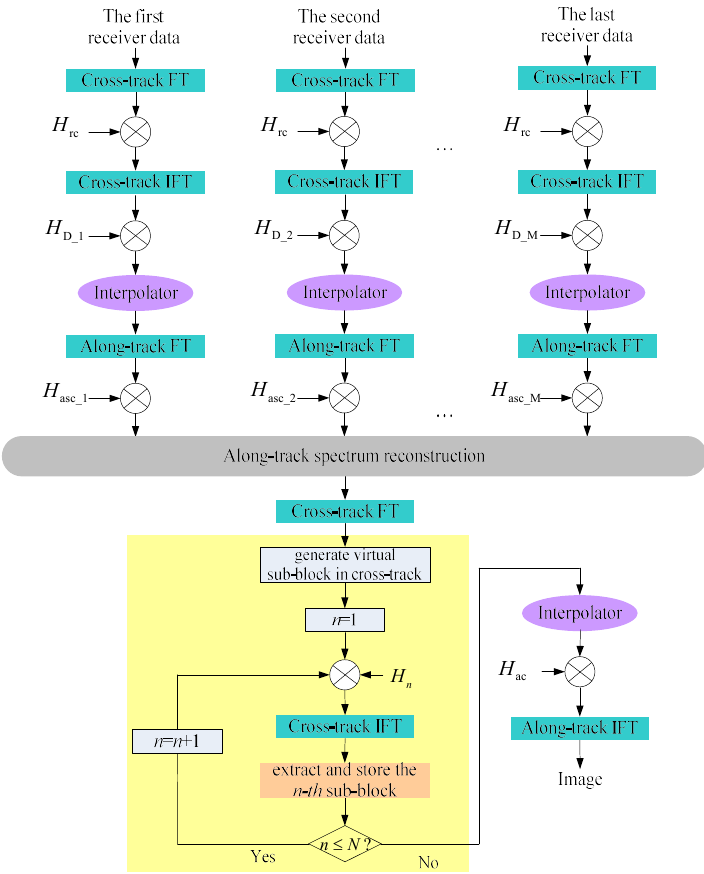
Figure 12. Block diagram of improved R-D algorithm.